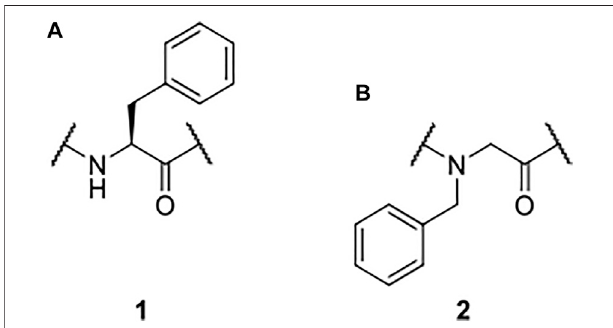
FIGURE 1 | Phenylalanine (Green and Loewenstein, 1988) as an example for an amino acid as the building block of a peptide (A) and N 1ph (FrankelandPabo,1988)asanexampleforanalkylatedglycinemonomer (B) .